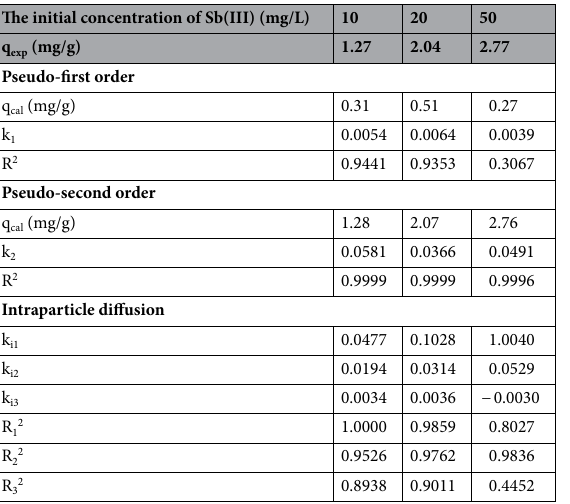
Table 2. The parameters of the adsorption kinetic